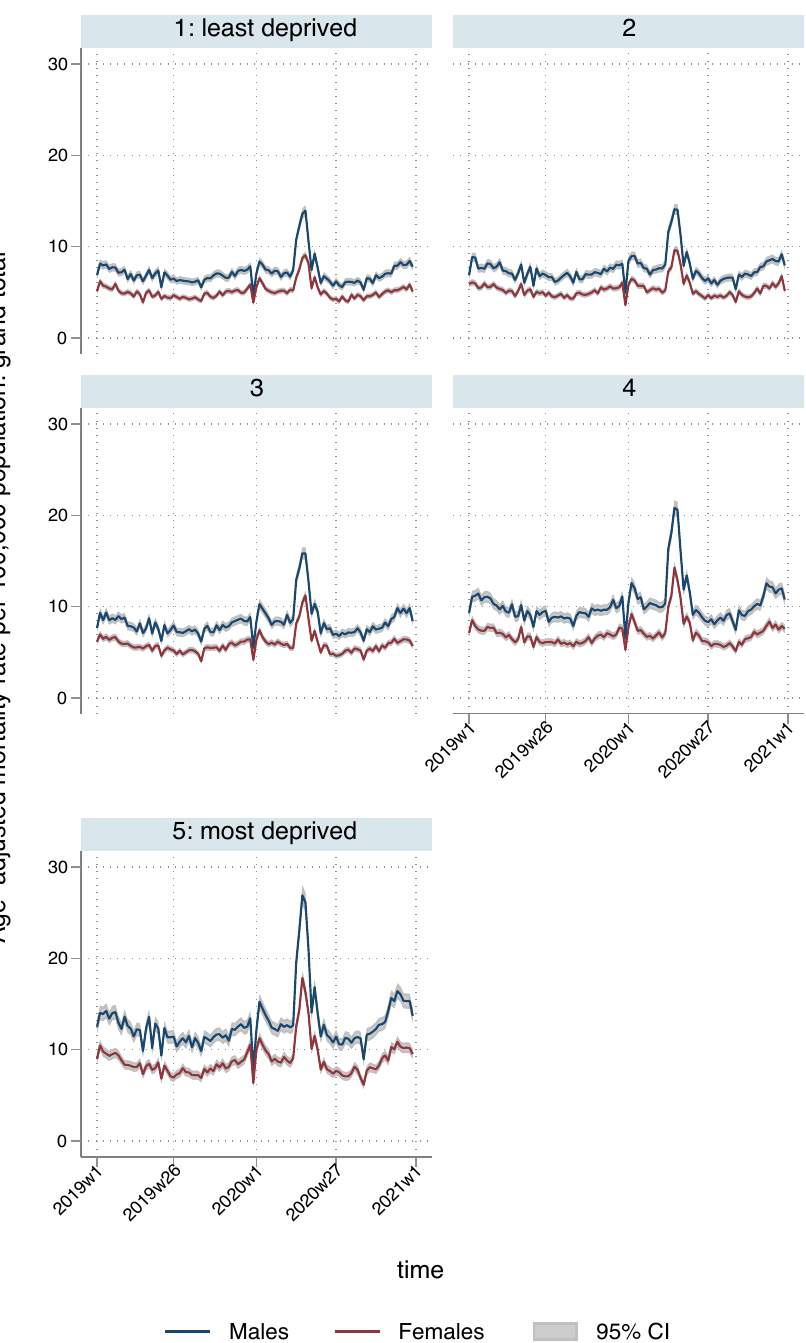
Fig 1. Temporal patterns in ASMRs per 100,000 population for all deaths, by sex and deprivation quintile. ASMR, age-standardised mortality rate. younger age groups. For ages 45 to 64: 3.00 (95% CI: 2.34 to 3.67); 65 to 74: 1.93 (95% CI: 1.51 to 2.34); 75 to 84: 1.38 (95% CI: 1.14 to 1.62); 85+: 0.95 (95% CI: 0.76 to 1.14). The North West and London had the highest number of excess deaths in people aged 74 or below. Interacting